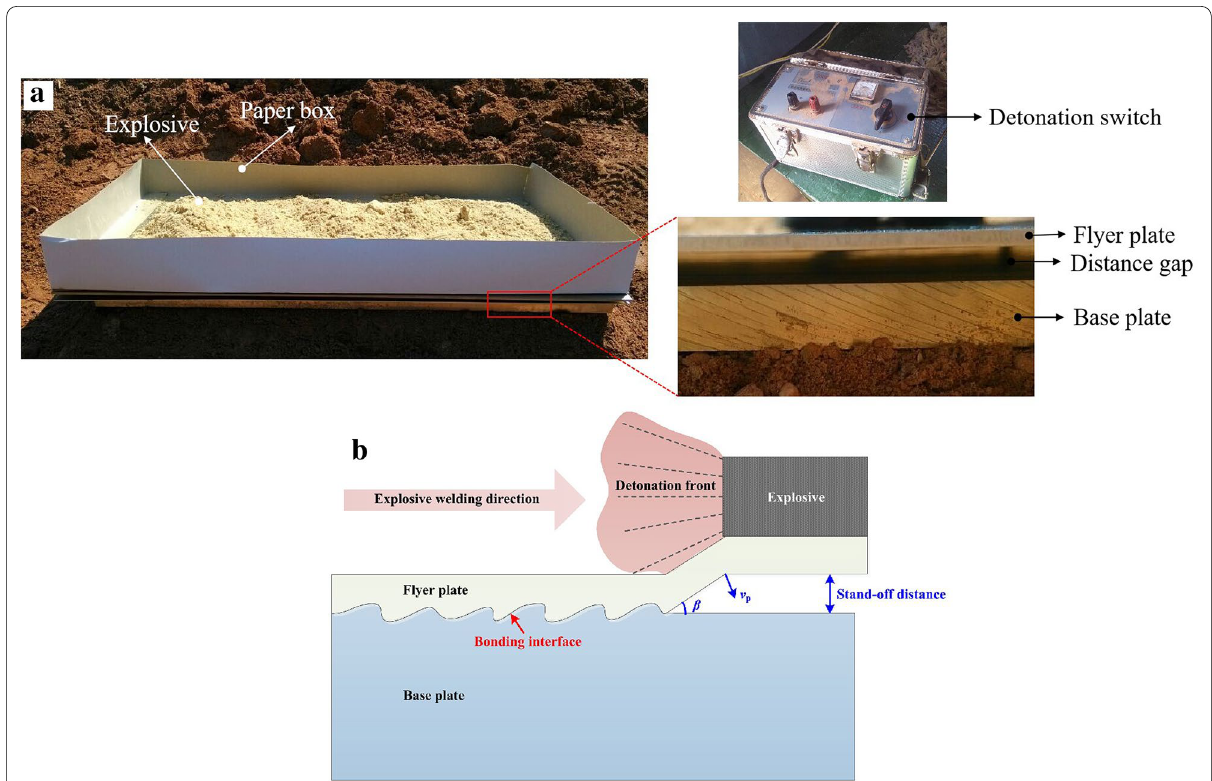
Figure 1 Installation diagrams of the explosive welding process